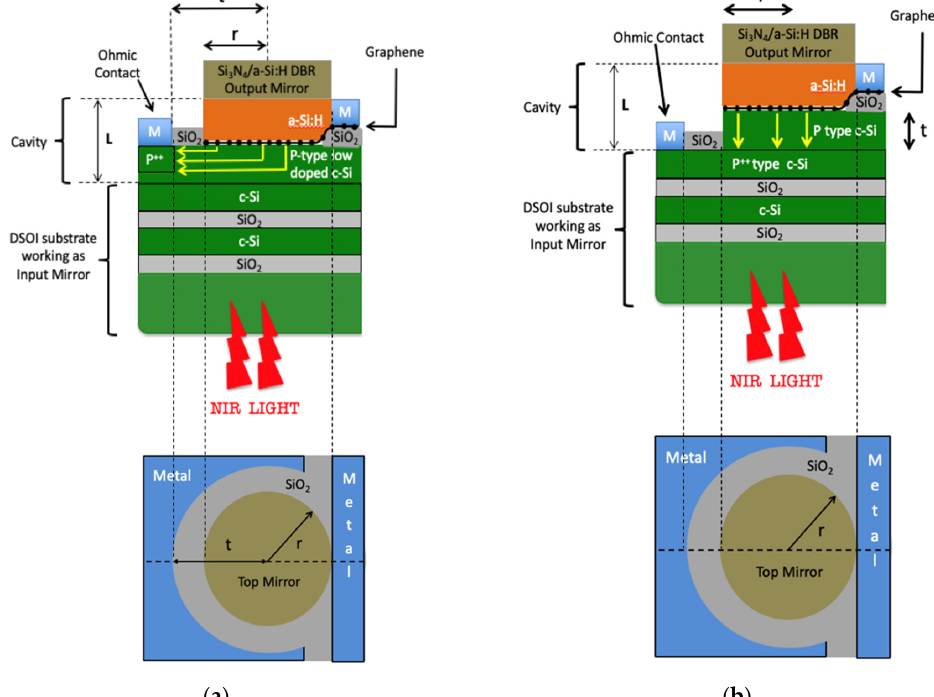
Figure 6. Sketch of the Fabry–Pérot graphene/Si Schottky PD in the ( a ) transverse and ( b ) longitudinal collection configuration.